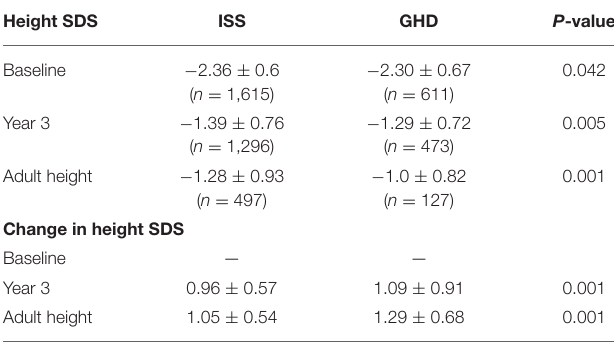
TABLE 2 | Change in height standard deviation score from baseline to adult